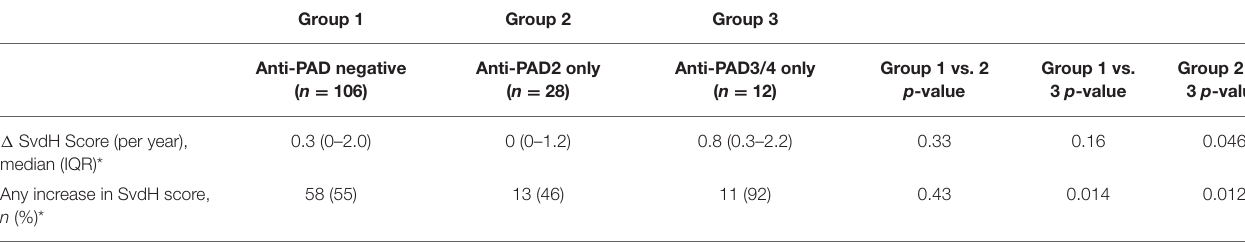
TABLE 3 | Progression of joint damage according to anti-PAD2 and anti-PAD3/4